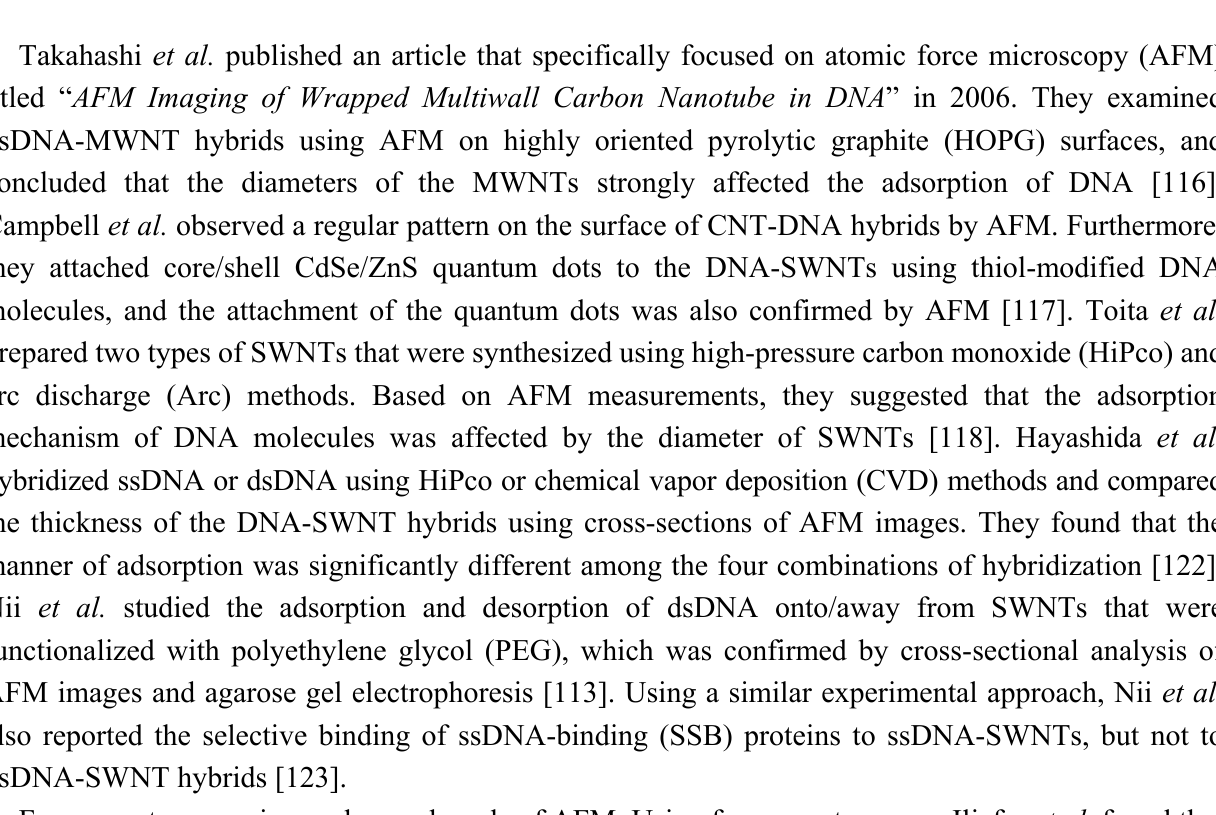
Figure 3. Differences in photoluminescence (PL) maps due to the pH values of solvents indicated by Kim et al. (Reprinted from reference [89] with